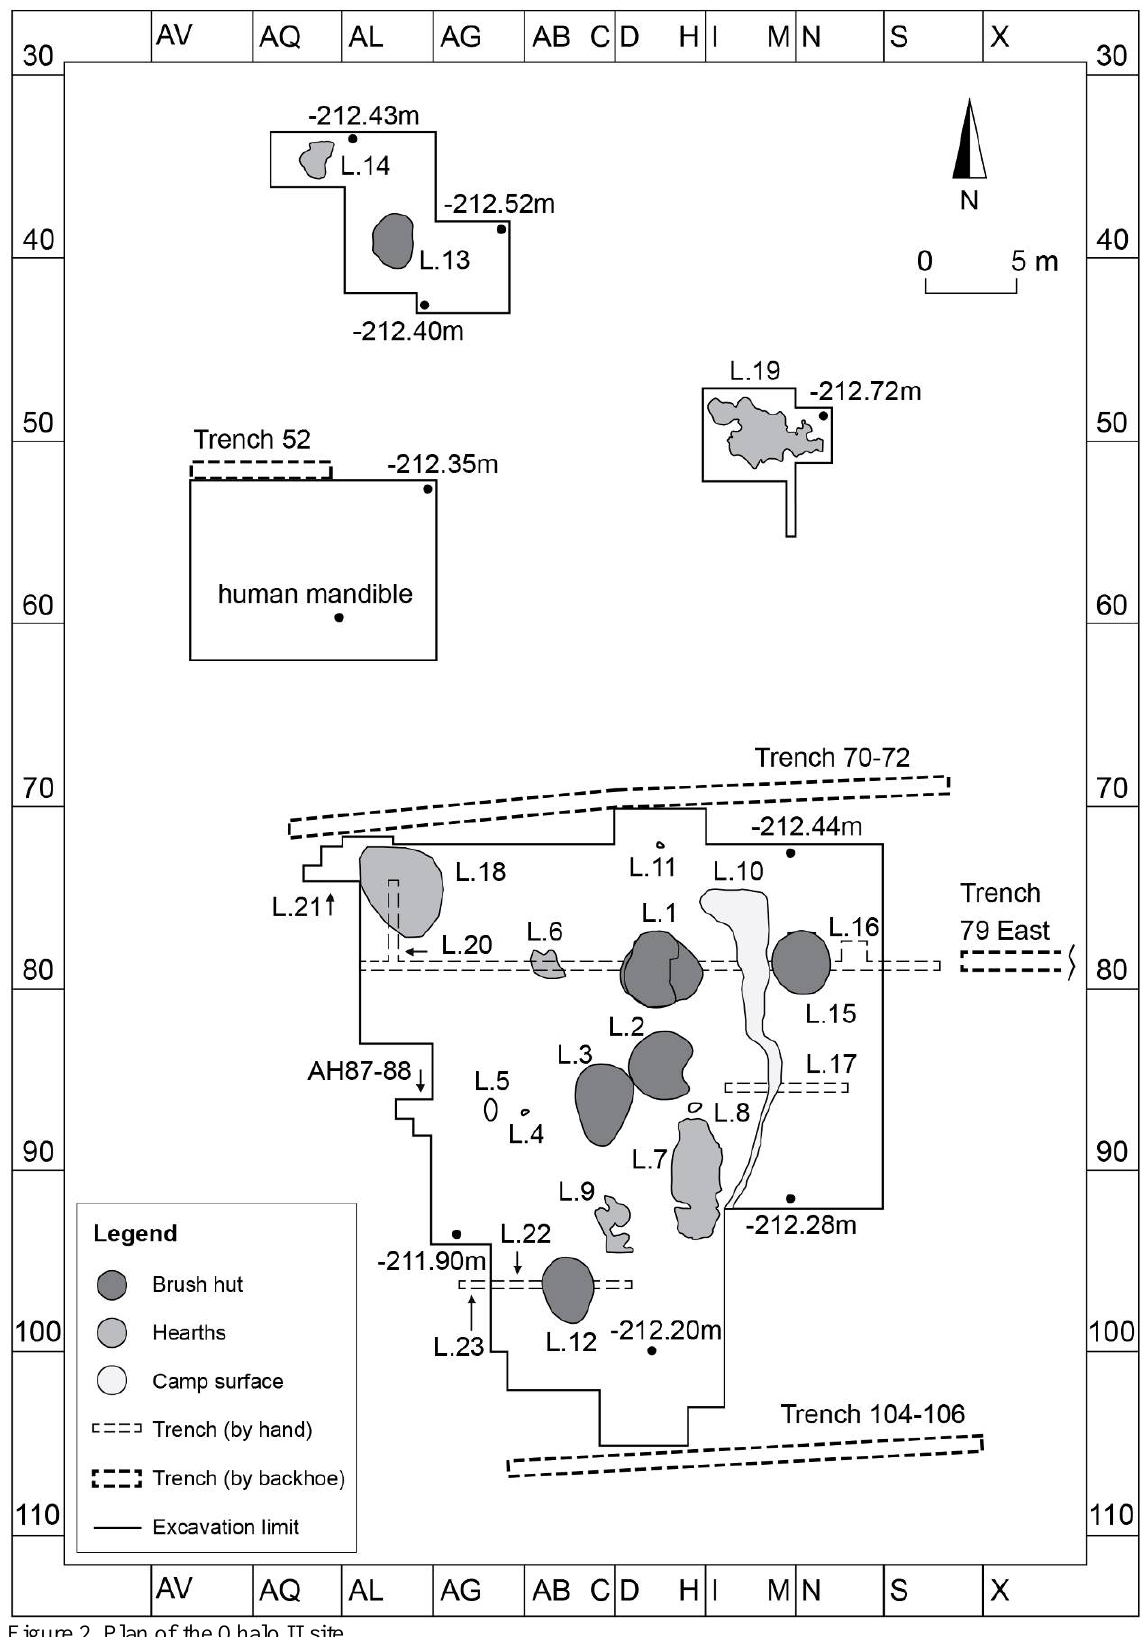
Figure 2. Plan of the Ohalo II